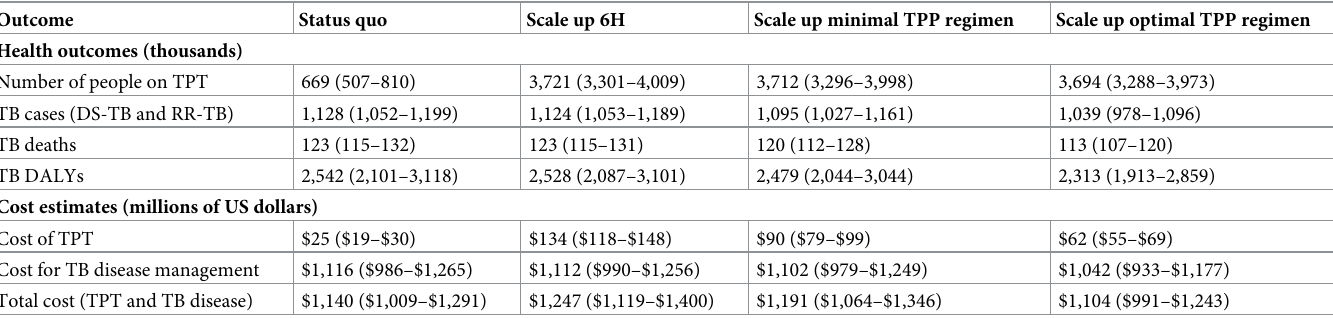
Table 2. Projected health impacts and costs (95% uncertainty ranges) for TPT and TB treatment: Brazil 2020–2035. Outcome Status